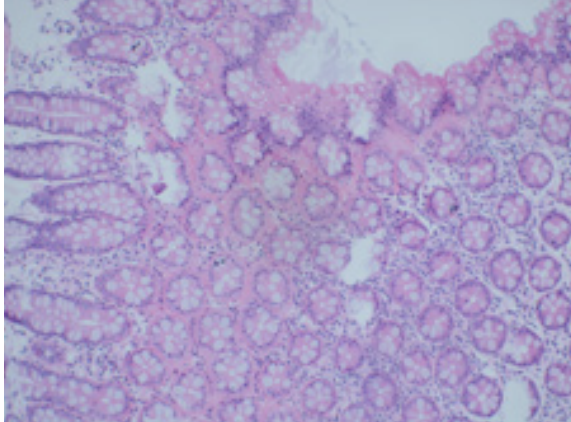
Figure 3: Intestinal biopsy revealed epithelium interstitial fibrosis indicating chronic mucosal inflammation along with lymphocyte infiltration.